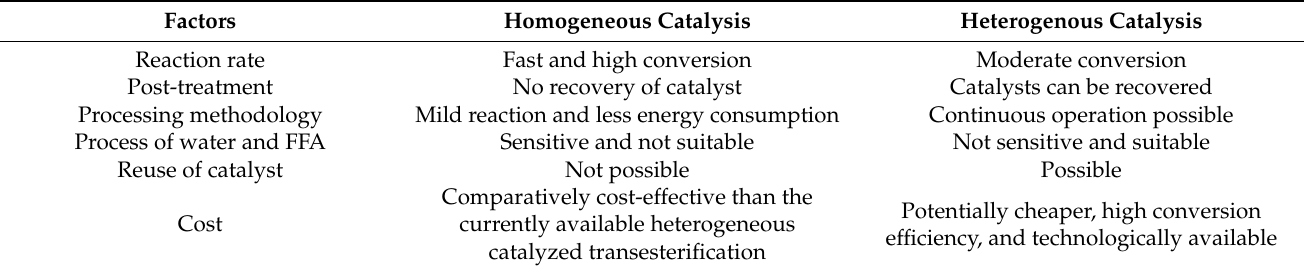
Table 8. Comparison of homogeneous versus heterogeneous-catalyzed transesterification process of biodiesel production, reported by